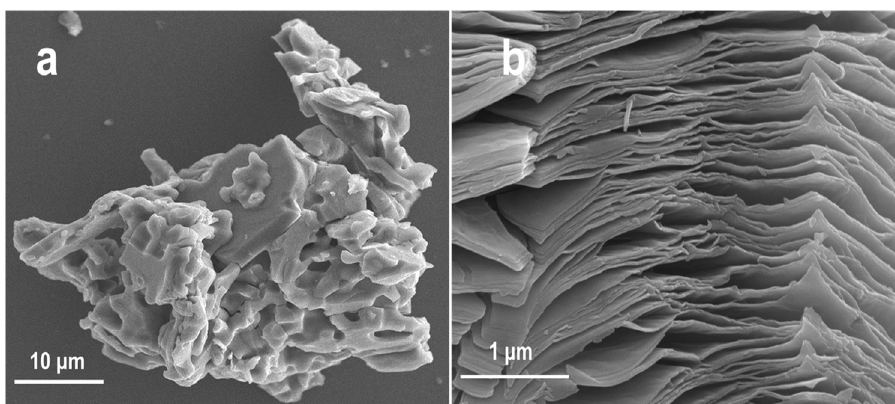
Figure 1. XRD patterns for Ti 3 AlC 2 and obtained Ti 3 C 2 by etching the Al layer of Ti 3 AlC 2 with HF solution.